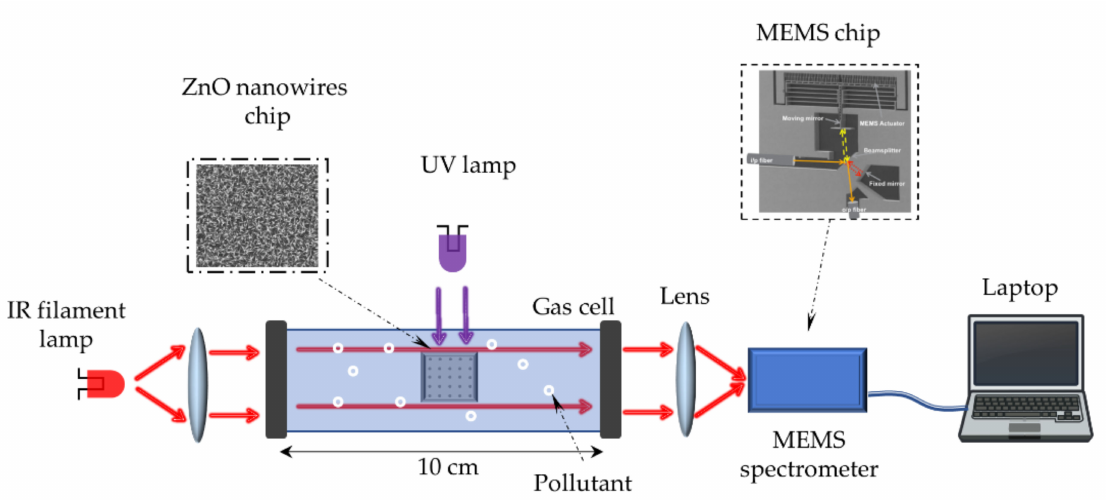
Figure 4. Experimental setup of pollutants purification within the gas cell by photocatalysis on ZnO-NWs chip. The depollution process is continuously monitored using MEMS spectrometer coupled to the gas